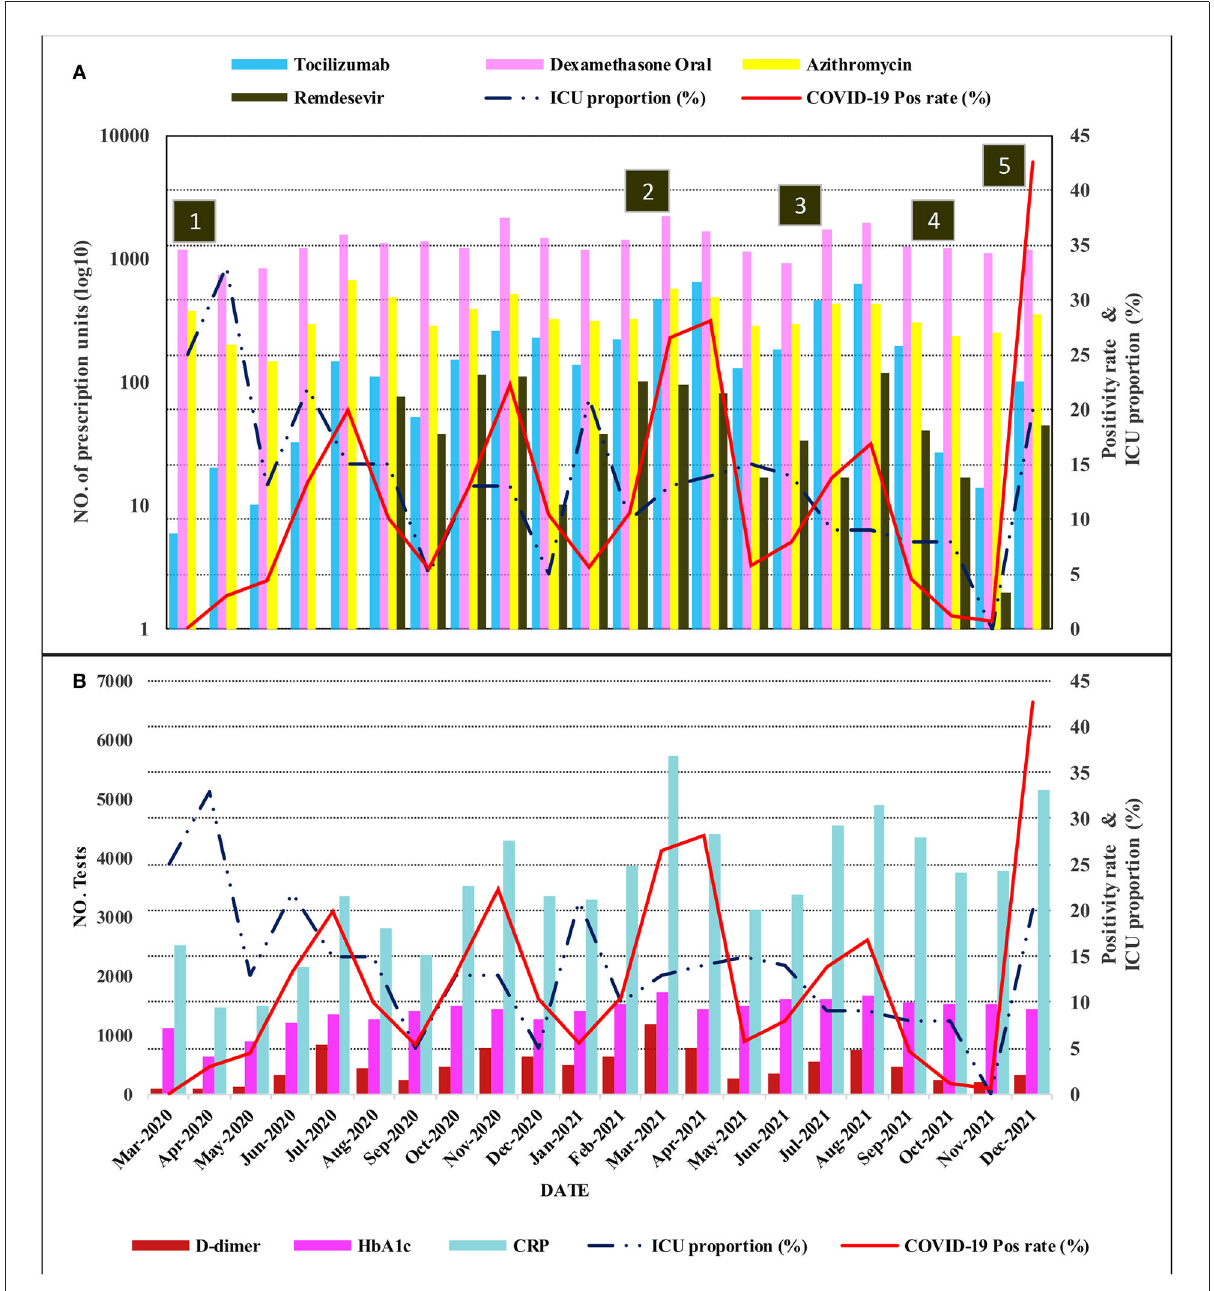
FIGURE1 Compound plot showing the trends in the positivity rate and proportion of patients in ICU as line graphs on the right vertical axes. The movement prescription drugs and laboratory tests are plotted on the left vertical axes using bar charts in (A,B) , respectively. The prescription drug scale is log10 transformed. The horizontal axis (time series from March 2020 to December 2021) is common for the vertically aligned plots (ICU, intensive care unit; CRP, C-reactive protein). Annotation in numbered squares : (1) Impositions of restrictions and curfew, (2) start of vaccination and rise of predominantly Alpha variant, (3) Delta variant wave, (4) Lifting of restrictions and curfew, (5) Omicron variant